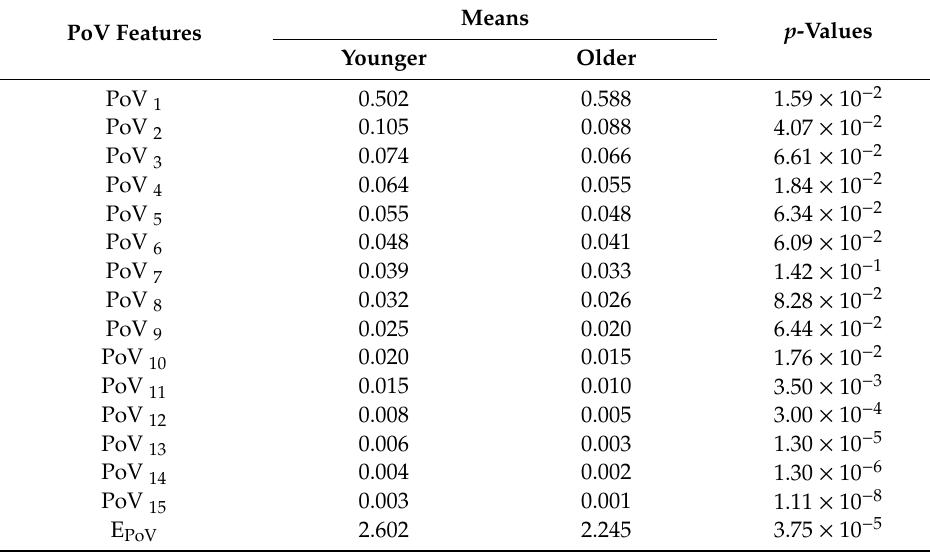
Figure 8. Proportion of variance (PoV) feature distribution curves of both age groups. Table 3. Summary of the comparative results of the PoV features.